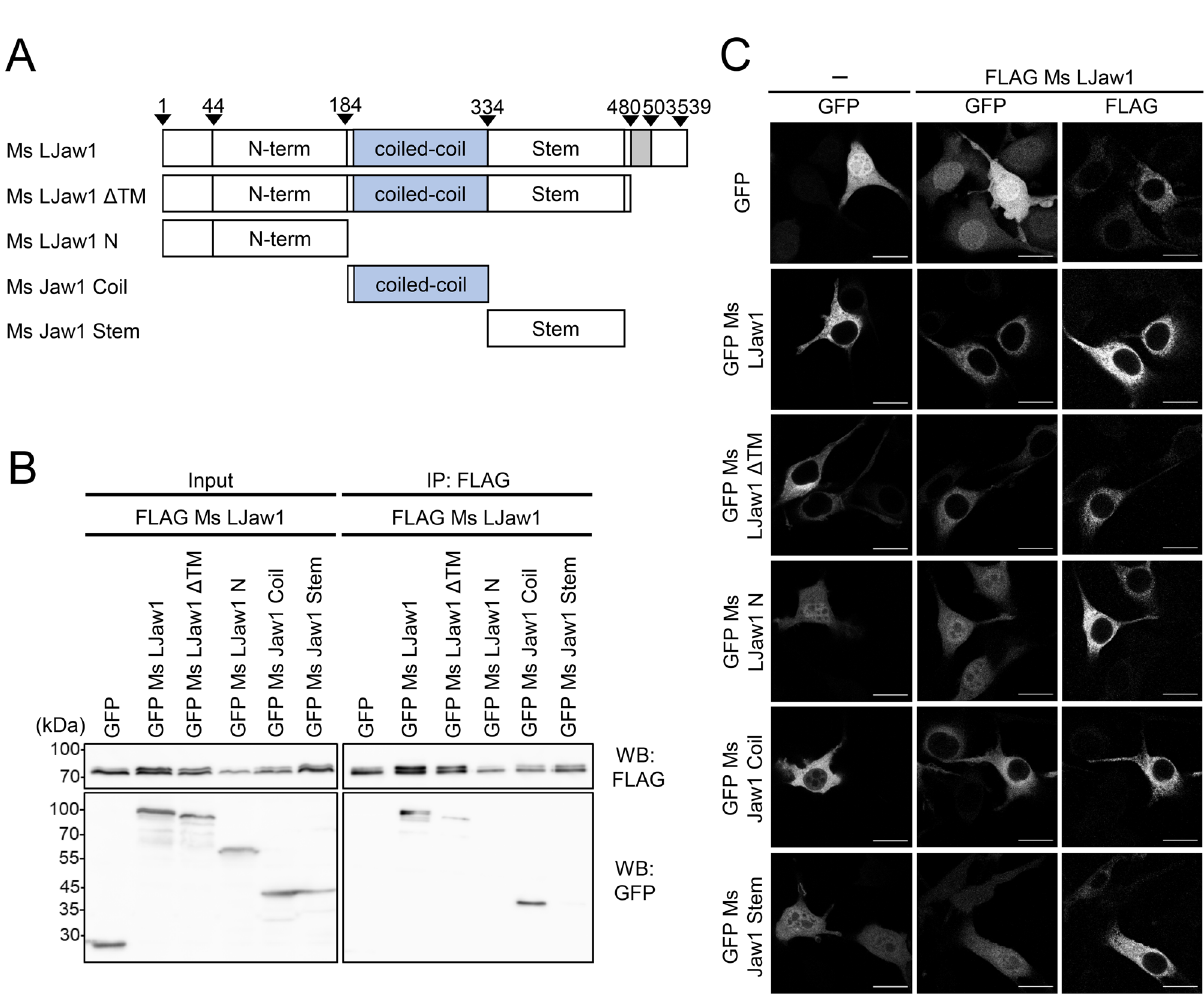
Figure 1. Identification of the cytosolic oligomerization site. ( A ) Schematic representation of Mouse LJaw1 (LJaw1; long form Jaw1) and mutants. N-term; N-terminal region, coiled-coil; coiled-coil domain, Stem; stem region, Gray box; single trans-membrane domain. ( B ) Identification of the oligomerization site by co-immunoprecipitation followed by western blotting. FLAG Ms LJaw1 was co-expressed with GFP, GFP Ms LJaw1 or mutants in HEK293 cells by transfection. After incubation for 24 h, the lysates were subjected to co-immunoprecipitation. For western blotting, an anti-FLAG rabbit antibody and an anti-GFP rabbit antibody as primary antibodies were used. ( C ) GFP, GFP Ms LJaw1 or mutants was expressed alone or co-expressed with FLAG Ms LJaw1 in B16F10 cells by transfection. After incubation for 24 h, the cells were subjected to immunostaining using an anti-FLAG rabbit antibody as a primary antibody. The images were acquired by confocal microscopy. Scale bar; 20